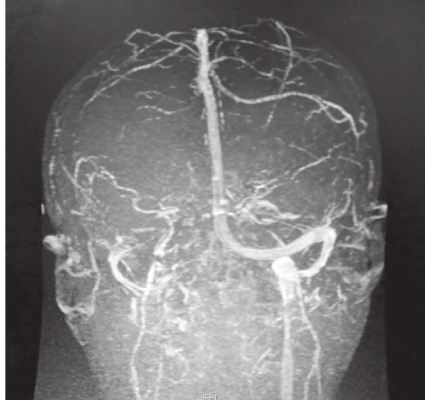
Figure 1: MRI and MRV brain showing no flow within the left transverse and sigmoid sinuses and also no flow within the left internal jugular vein.